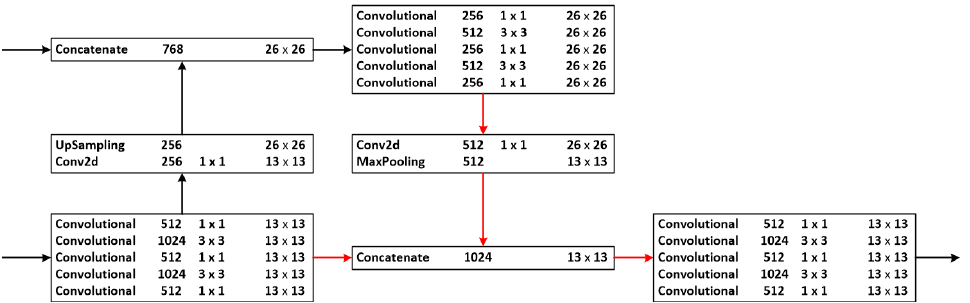
Figure 10. Multi-scale feature fusion of multiple